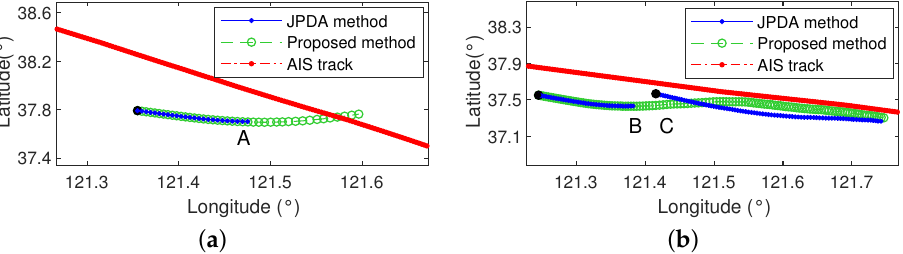
Figure 15. Comparison of tracking results obtained by JPDA and proposed methods. ( a ) Comparison of tracking results for T1. Point A indicates the position where the track breaks. ( b ) Comparison of tracking results for T2. Point B and point C indicate the positions where the track breaks and restarts,